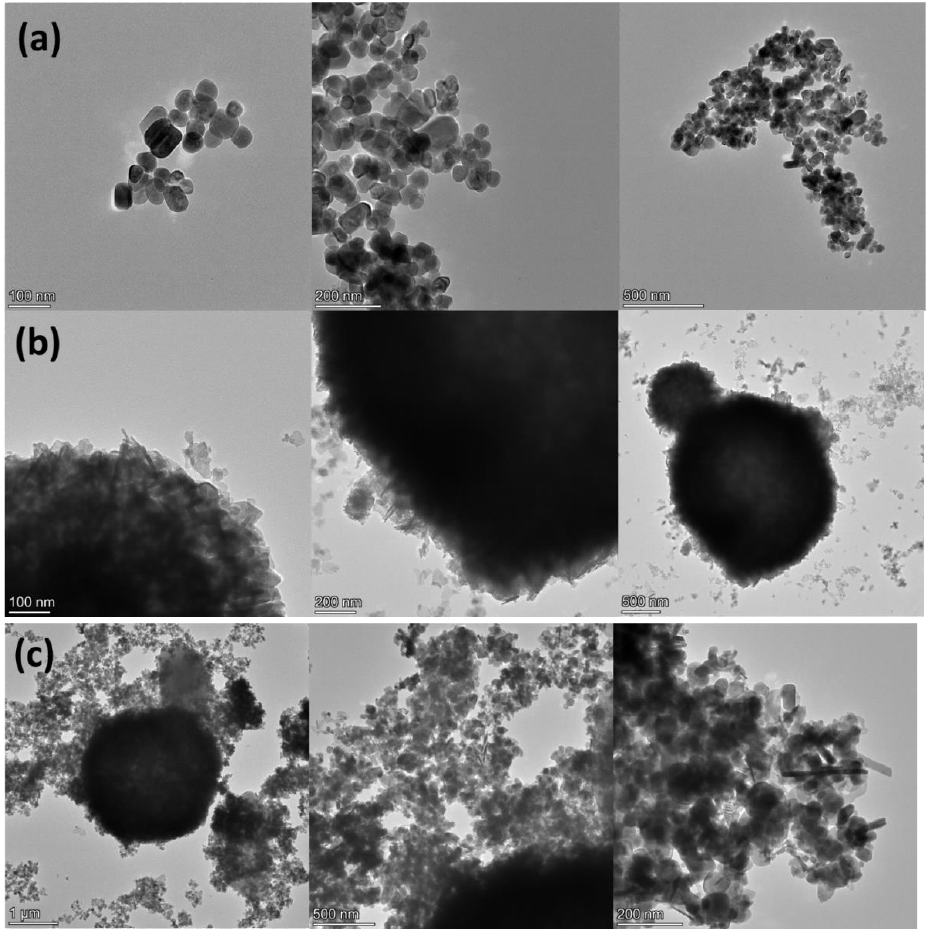
Figure 4. TEM images of ZnO ( a ), BMO ( b ), and BZO ( c ). The elemental mapping of BZO (Figure 5) confirmed the presence of Bi, Mo, O, and Zn elements in the composite. The XPS data in the following were also consistent with these results. The presence of Zn element can be clearly seen in the energy spectrum, and the ZnO nanoparticles were uniformly distributed on the surface of BMO. The flower-like structure of BMO was basically preserved.